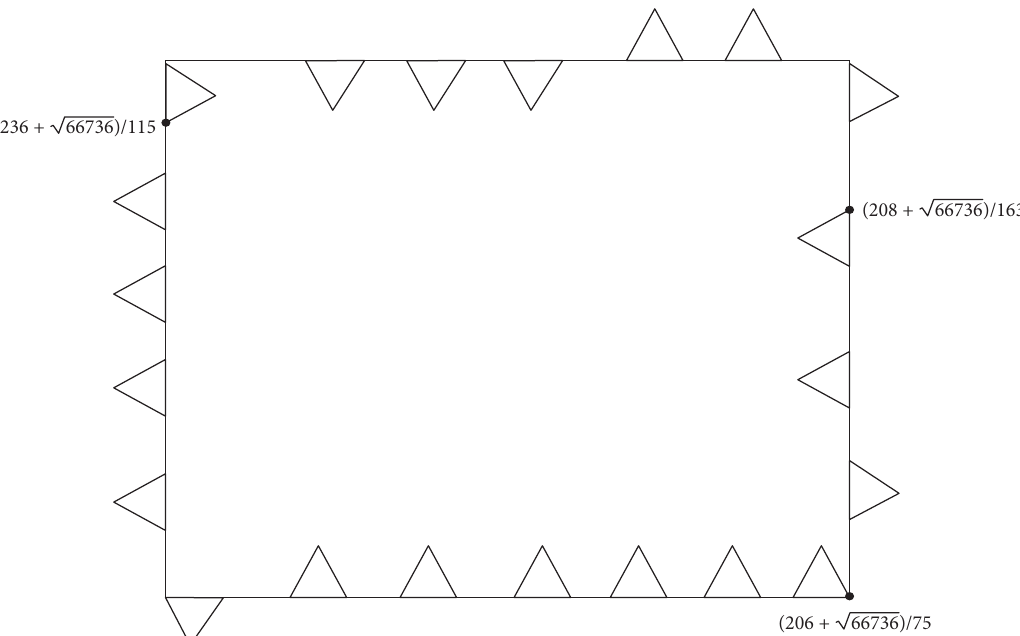
Figure 1: Shows the location of reduced numbers and describes that [ 1 , 2 , 3 , 4 , 5 , 6 ] ∼